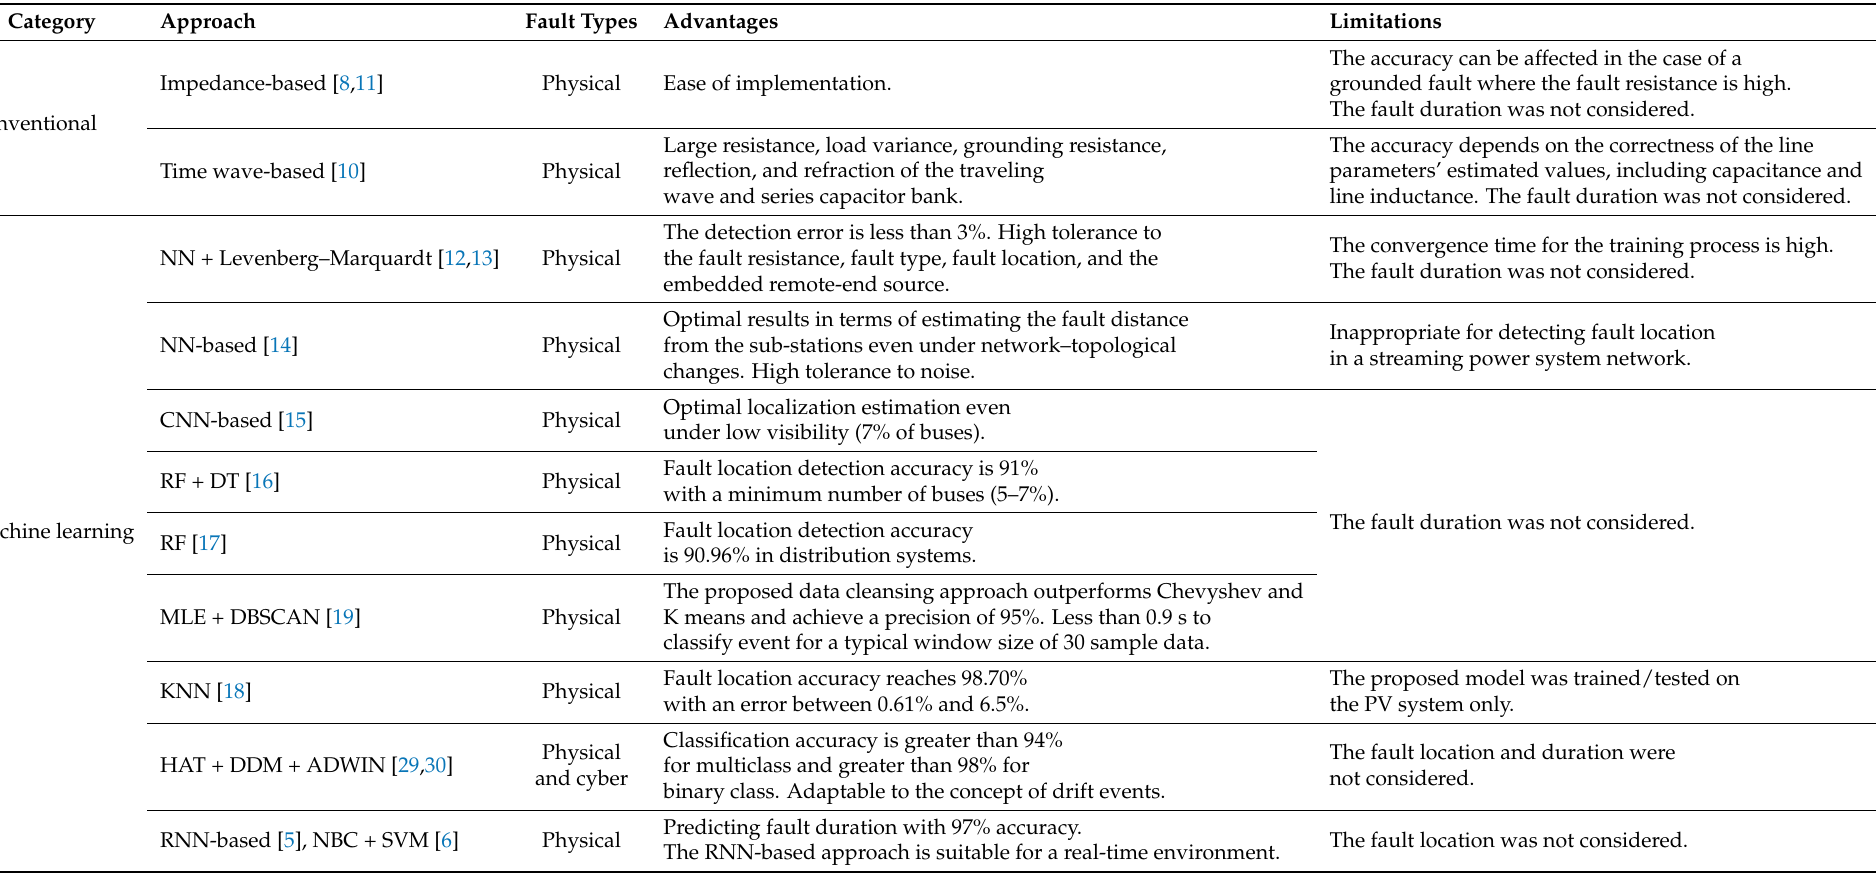
Table 1. Existing literature on fault location and duration in power